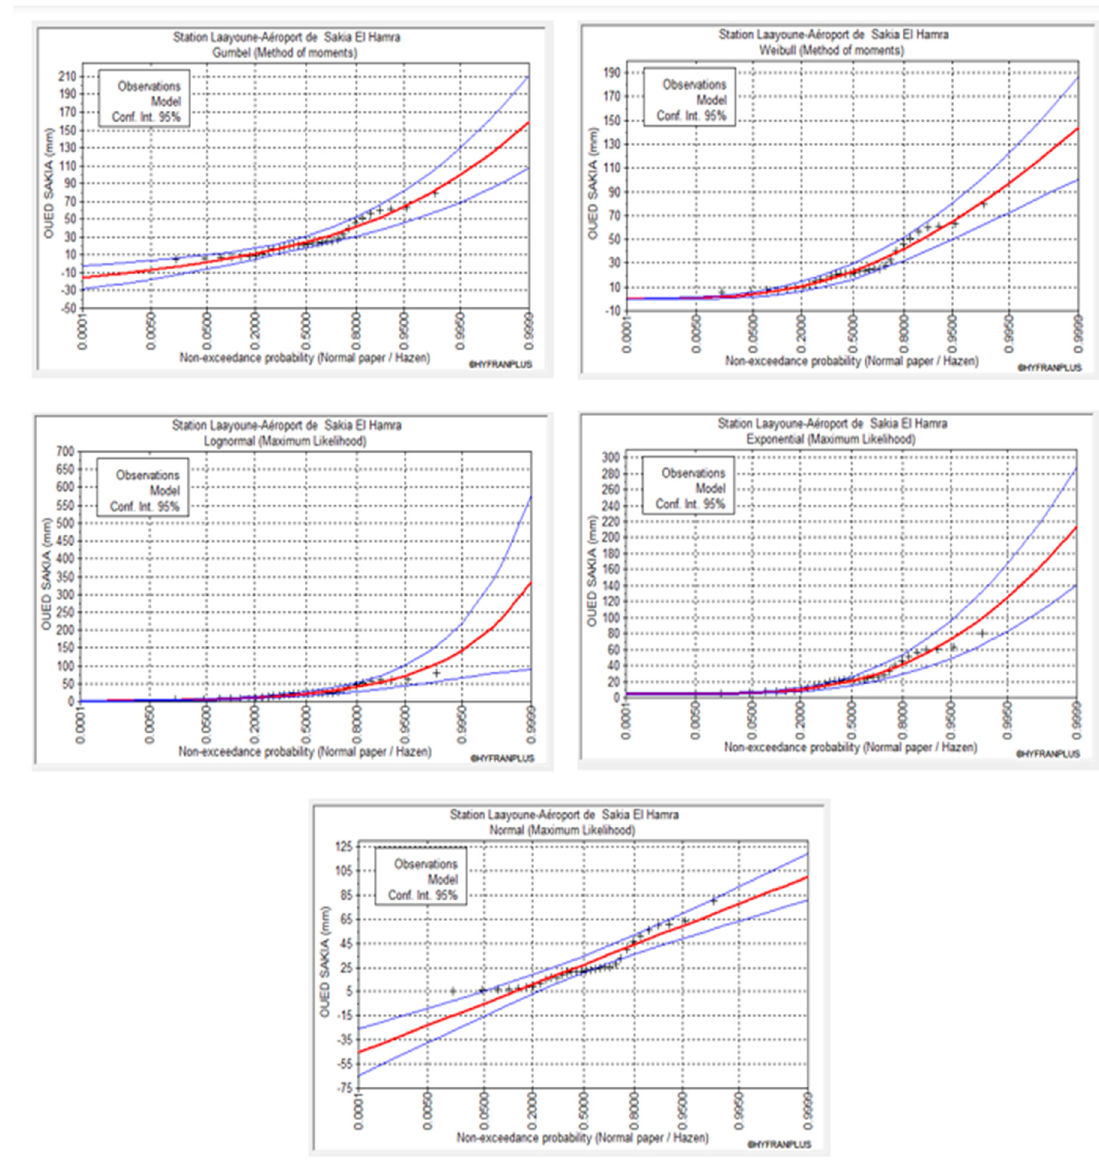
Figure 8. Monthly mean evaporation recorded for 1993 to 2002.